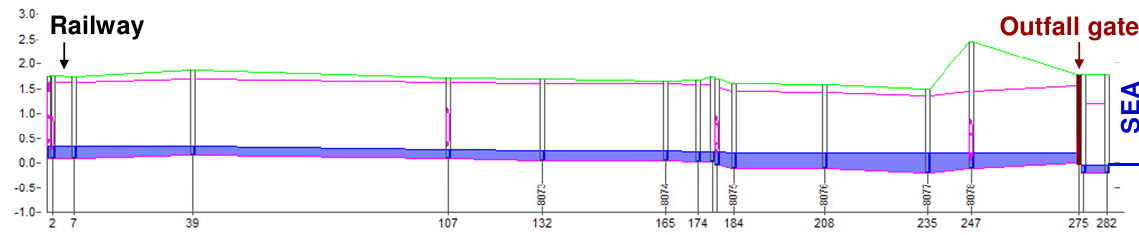
Fig. 4. Sortie channel: longitudinal profile of the final stretch (distances in m, elevations in